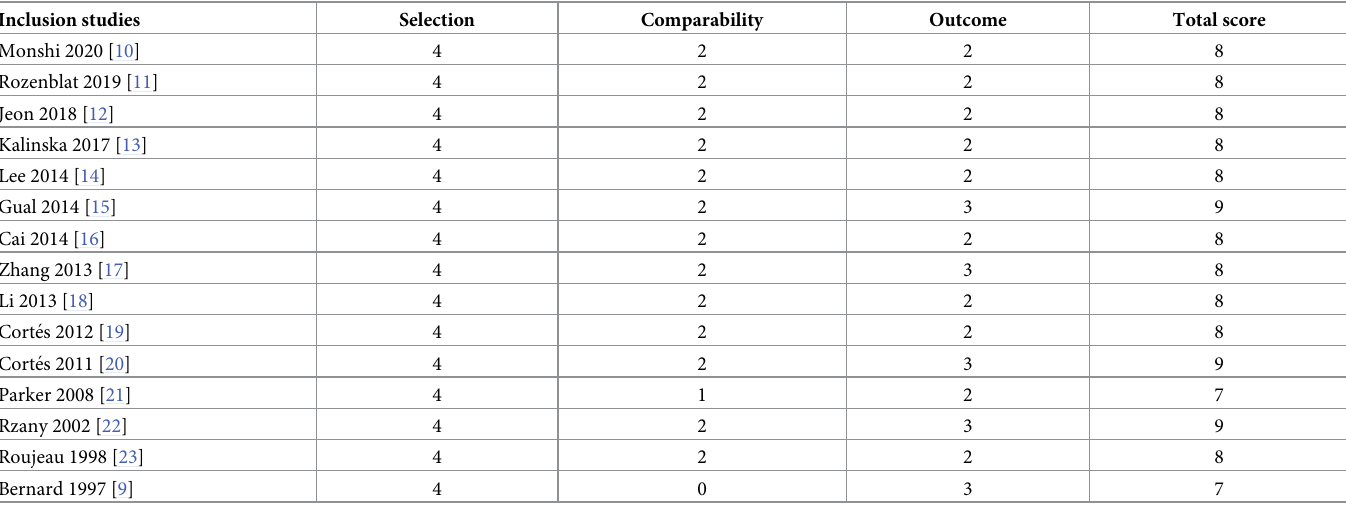
Table 2. The quality assessment of included studies.